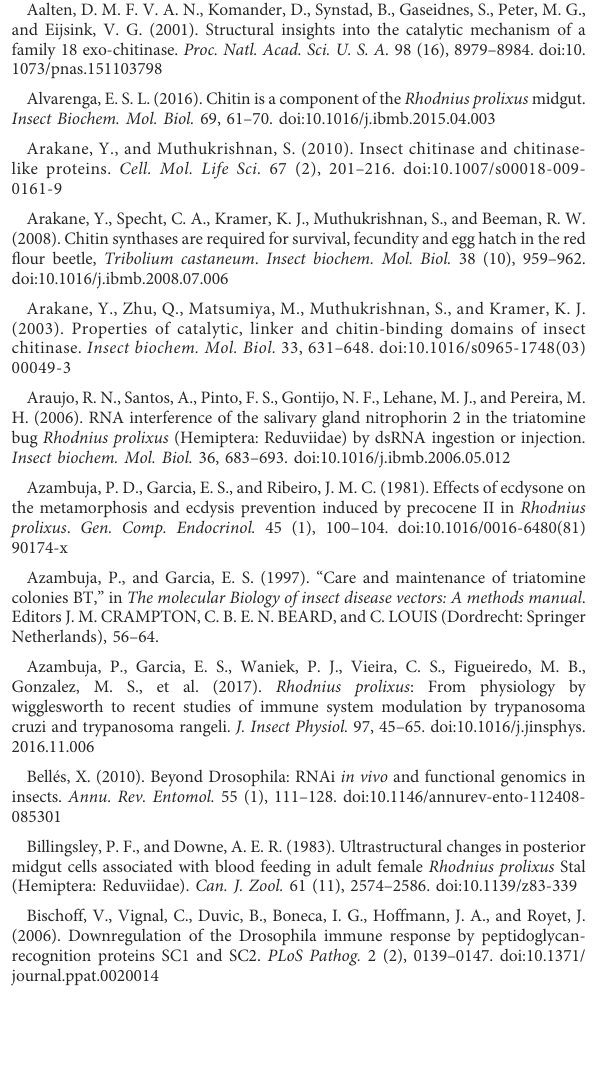
SUPPLEMENTARY TABLE S2 Summaryofthecharacteristicsofgenescodingproteinsbelongingtothe family 18 of glycoside hydrolases in the genome of R. prolixus . Vector base: code of vector base from chitinase genes. Signal IP 4.1 e Signal IP 3.0: signal peptides. Phobius: transmembrane topology and signal peptides pI:Isoelectric point. MW: Molecular weight.N-Glyc: numberof N-linked glycosylations. O-Glyc: number of O-linked glycosylations. GPI: Identi fi cation of GPI anchor signals. Hmmtop: location of helical transmembrane segments. SUPPLEMENTARY TABLE S3 Comparison of exon number of R. prolixus sequences with Anopheles gambiae , Aedes aegypti , and Pediculus humanus sequences of each group of the phylogenetic tree. RpCht: Rhodnius prolixus. PhCht: Pediculus humanus. AgCht: Anopheles gambiae. AaCht: Aedes aegypti. SUPPLEMENTARY TABLE S4 Comparison of chitinase predicted proteins ’ molecular masses with the average/range of chitinase molecular masses in the groups from phylogenetic trees. RpCht: Name of R. prolixus chitinases. MW (Kda) RpCht: Molecular mass of R. prolixus chitinases. Group: Number of chitinase groups in the phylogenetic tree. MW (Kda) Group: Molecular mass average of chitinases group in the phylogenetic